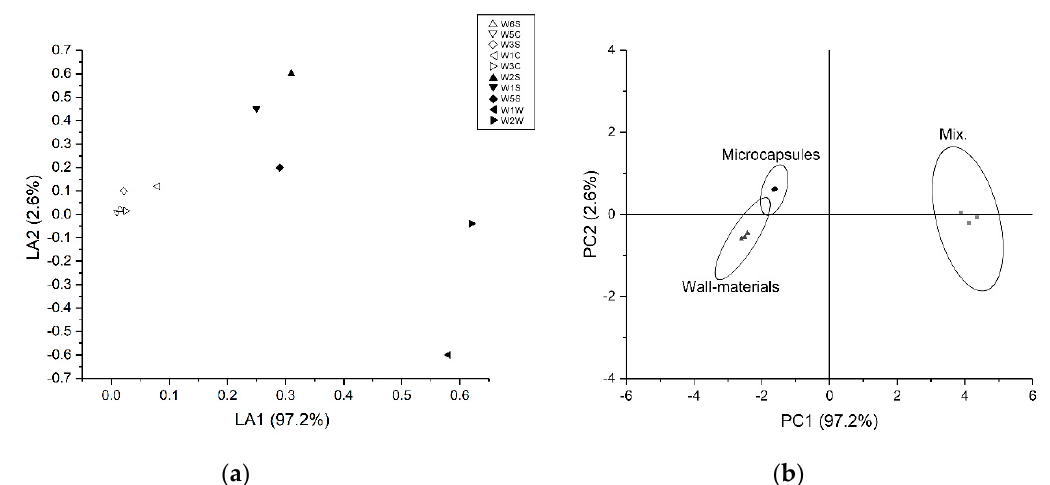
Figure 6. Loading analysis (LA) and principal component analysis (PCA) results for the electronic nose: ( a ) LA and ( b ) PCA.